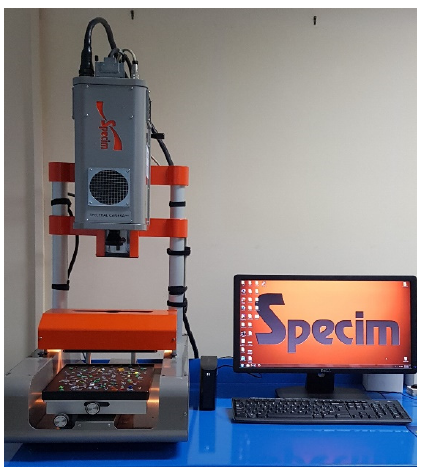
Figure 2. Sisuchema XL TM chemical imaging workstation (Specim Ltd.). Table 1. SISUCHEMA XL TM details (SWIR range).